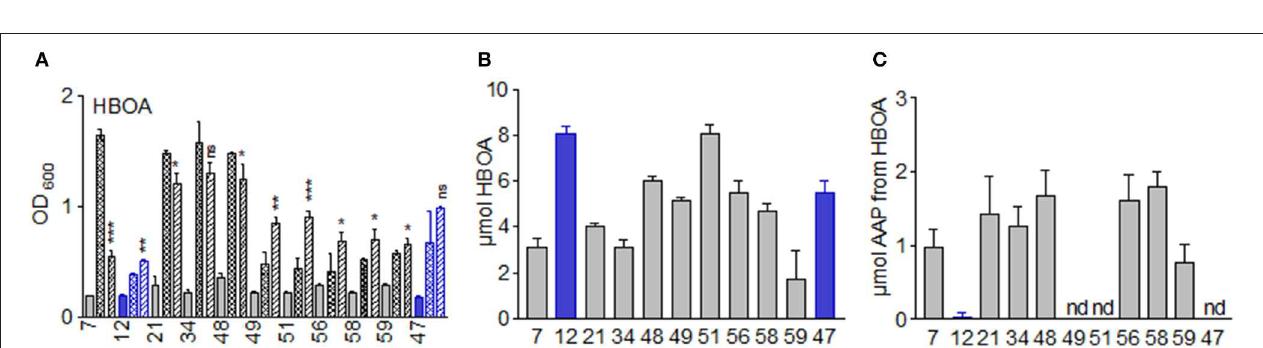
FIGURE 12 | UHPLC chromatogram of the brown-yellowish supernatant of the centrifuged cultures of Paenibacillus polymyxa ( 51 ) and Aminobacter aminovorans ( 49 ) after incubation with AAP. Compound eluting at 4.75 min: N -(2-hydroxy-5-nitrophenyl)-acetamide.